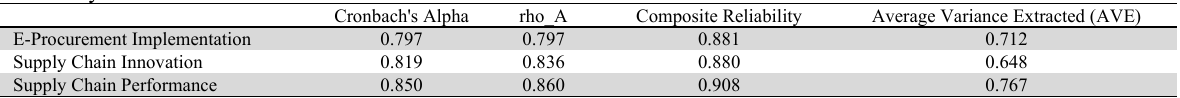
Reliability Test